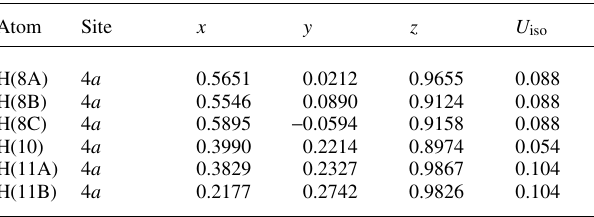
Table 2. Atomic coordinates and displacement parameters (in Å 2 ) .